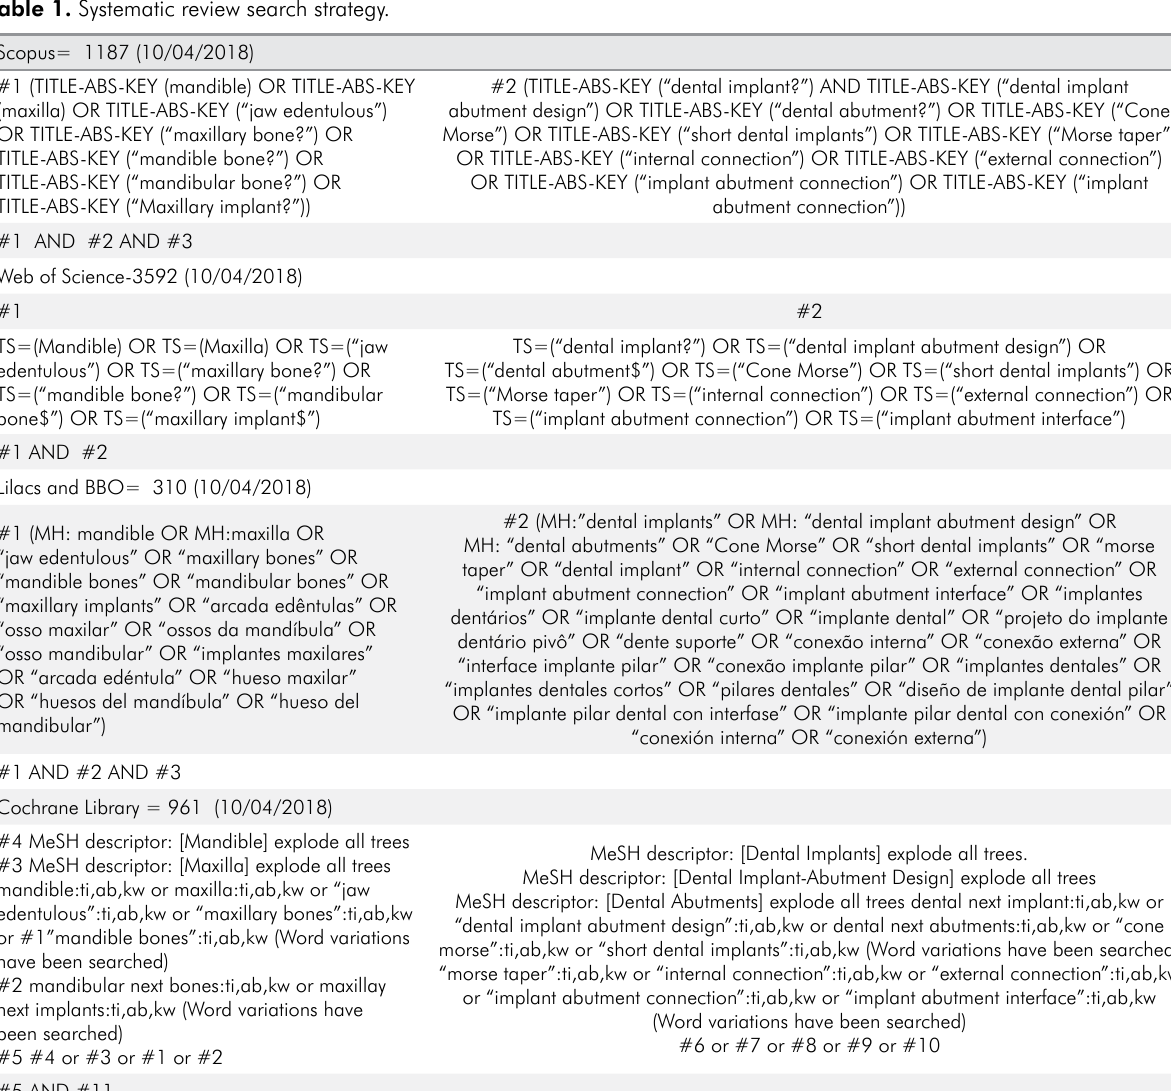
Table 1. Systematic review search